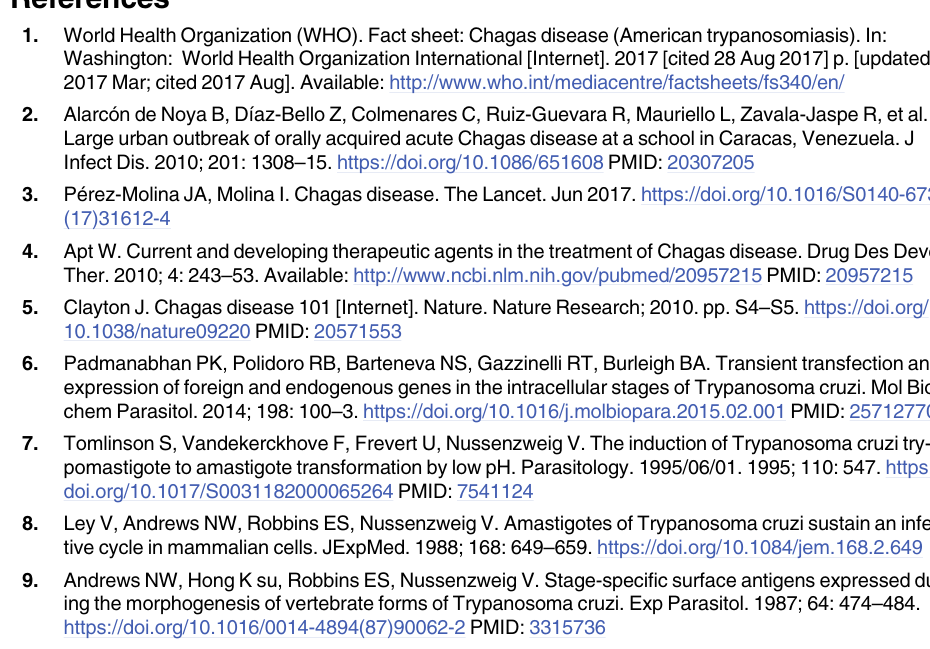
S2 Table. Transfection efficiency in axenic amastigotes of T . cruzi with various electropo- ration pulse programs. Mean values ( ± SD) of 3 independent experiments are